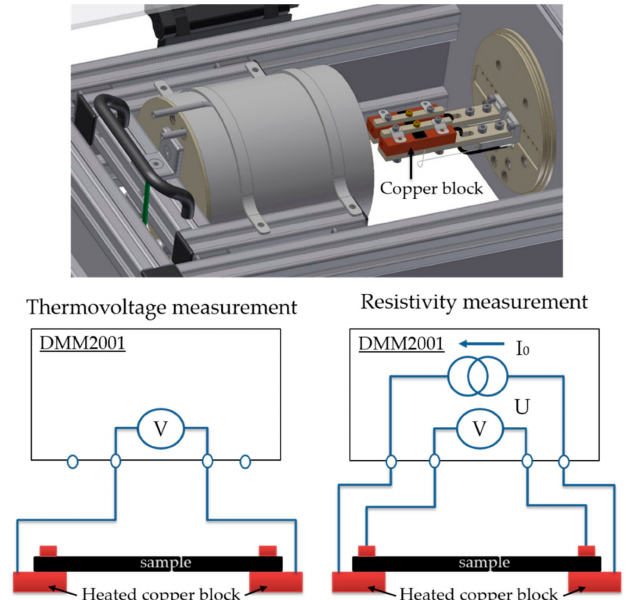
Figure 2. Schema and circuit diagram of the self-constructed device TEG for thermoelectric measurements of polymer-based